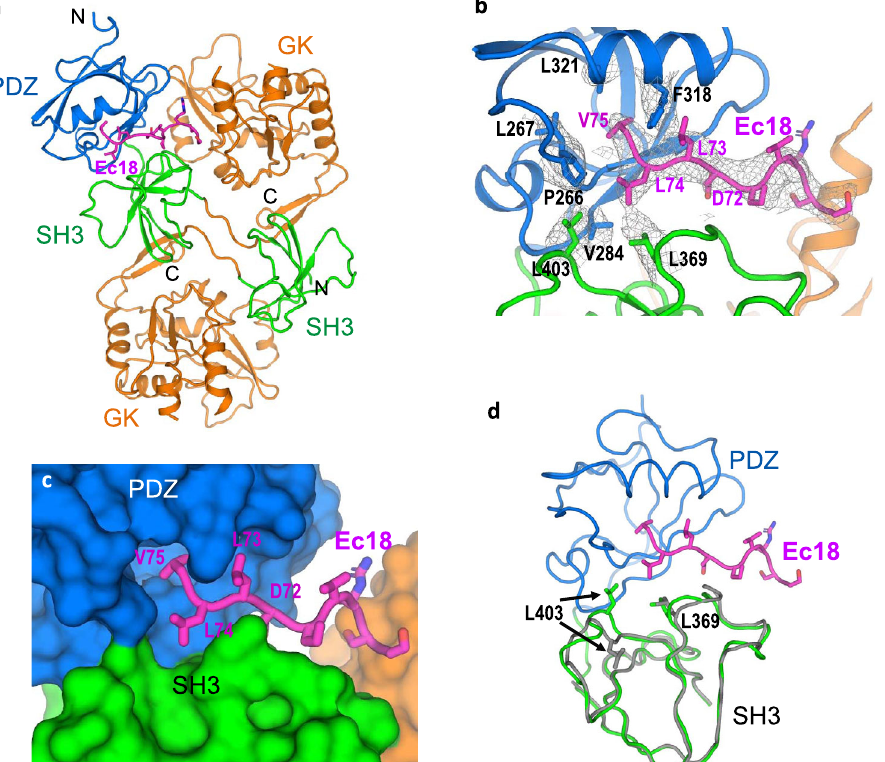
Fig. 2 Recognition of the PALS1 PDZ and SH3 domains by the E PBM. a Structure of the PSG – Ec18 complex shown as cartoons with different colors for different domains. Ec18 is shown as magenta sticks. b Binding site structure. Hydrophobic residues forming the binding pocket were shown as sticks. Potential density map for the binding site is shown as gray isomeshes contoured at 5.5 σ . c Surface representation of the binding site with Ec18 showing as sticks. d Superimposition of the two PSG monomers to show conformational changes in SH3 domains. The PDZ domain in the second monomer is disordered.